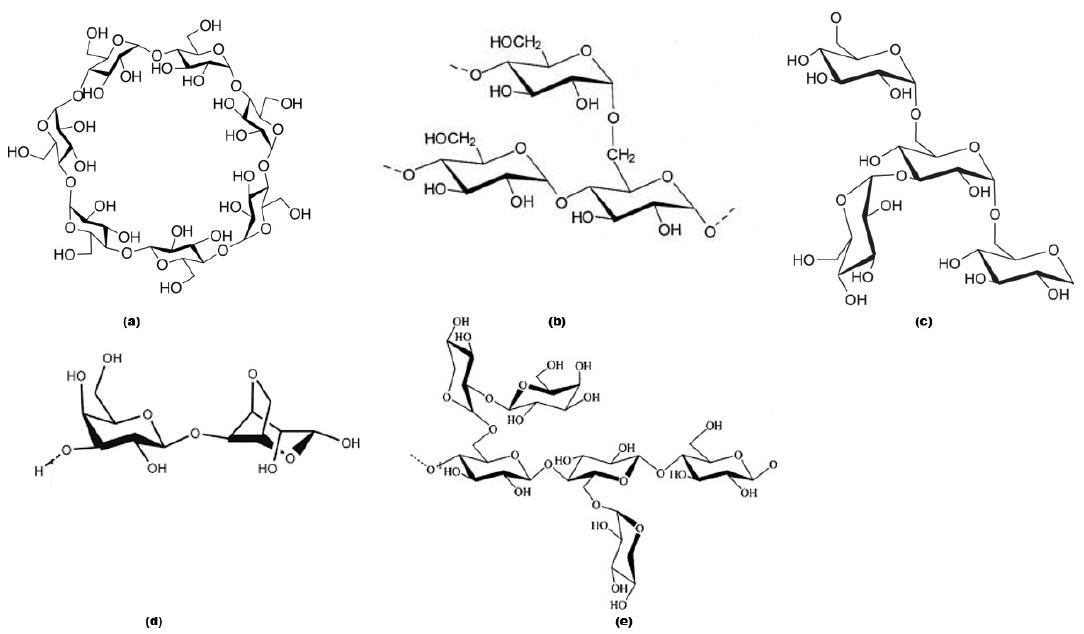
Figure 1. Chemical structures of the substrates: ( a ) β -cyclodextrin, ( b ) potato starch, ( c ) dextran, ( d ) agar agar, ( e ) tamarind.